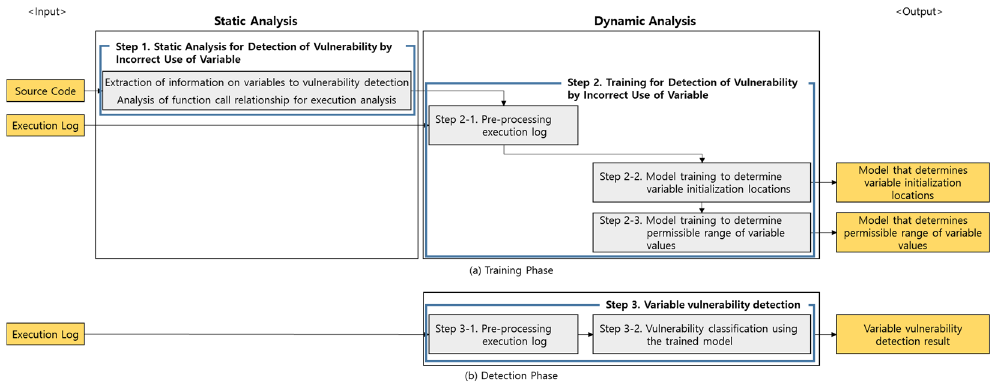
Table 1. Target defects related to incorrect use of variables to be detected.